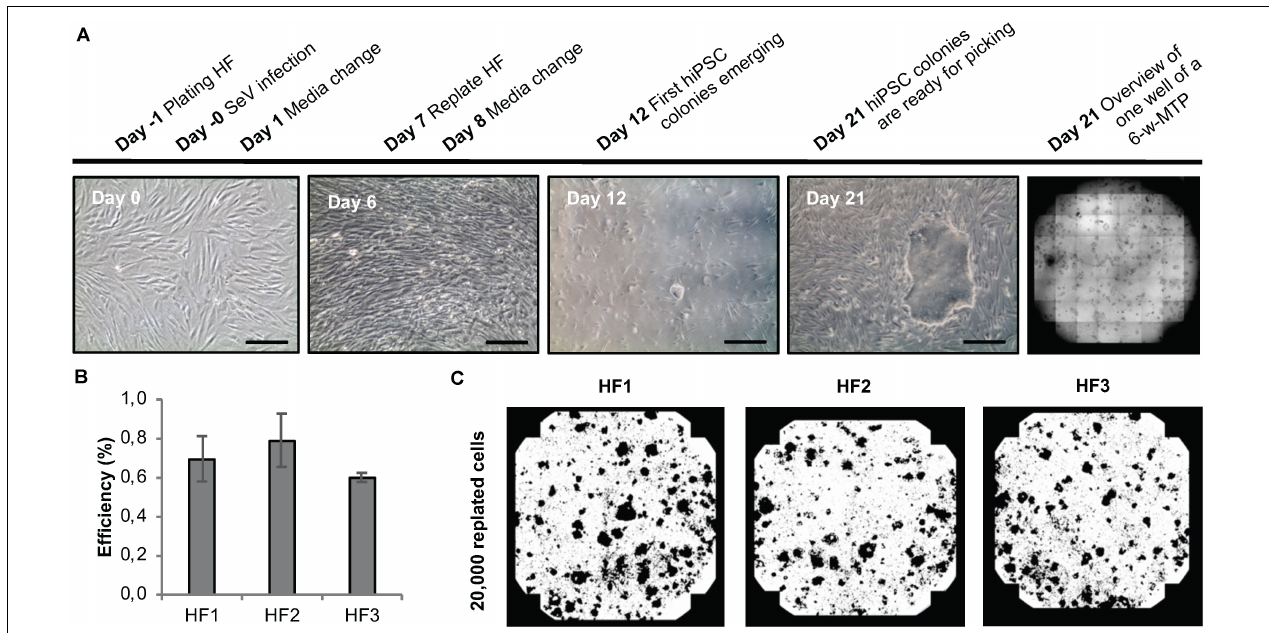
FIGURE 5 | Sendai virus-based reprogramming protocol suitable for automation. (A) Reprogramming scheme and emergence of clones. Key time points and processing steps are indicated. (B) Reprogramming efficiency assessed 21 days after infection of three different human fibroblast populations. Shown are mean values ± SD ( n = 9). (C) Representative whole-well binary images of single wells of a 6-well plate at day 21 post infection show cell colonies in black and cell-free areas in white. Scale bars: 100 µ m. HF, human